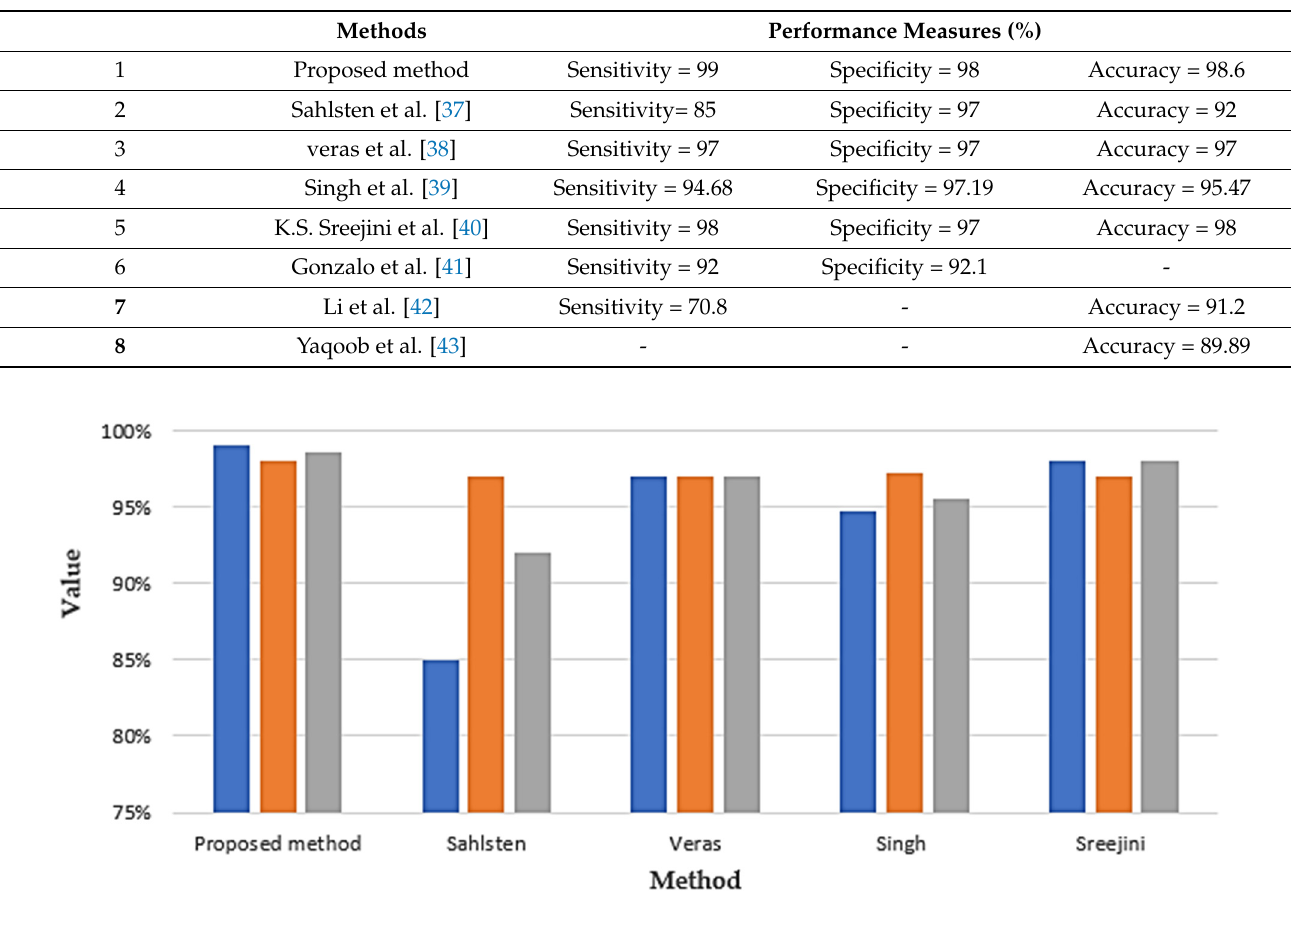
Table 3. Results were obtained by comparing the presence of disease on the MESSIDOR database.